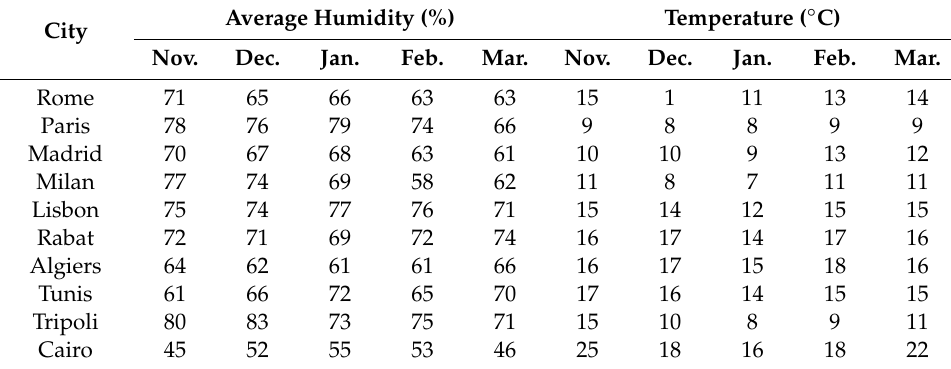
Table 3. Average humidity and temperature in 10 di ff erent cities in Europe and North Africa between November 2019 to March 2020. The first five cities represent significant communities where transmission of COVID-19 was reported, whereas the second 5 cities are expected to be less exposed to COVID-19 due to di ff erent weather